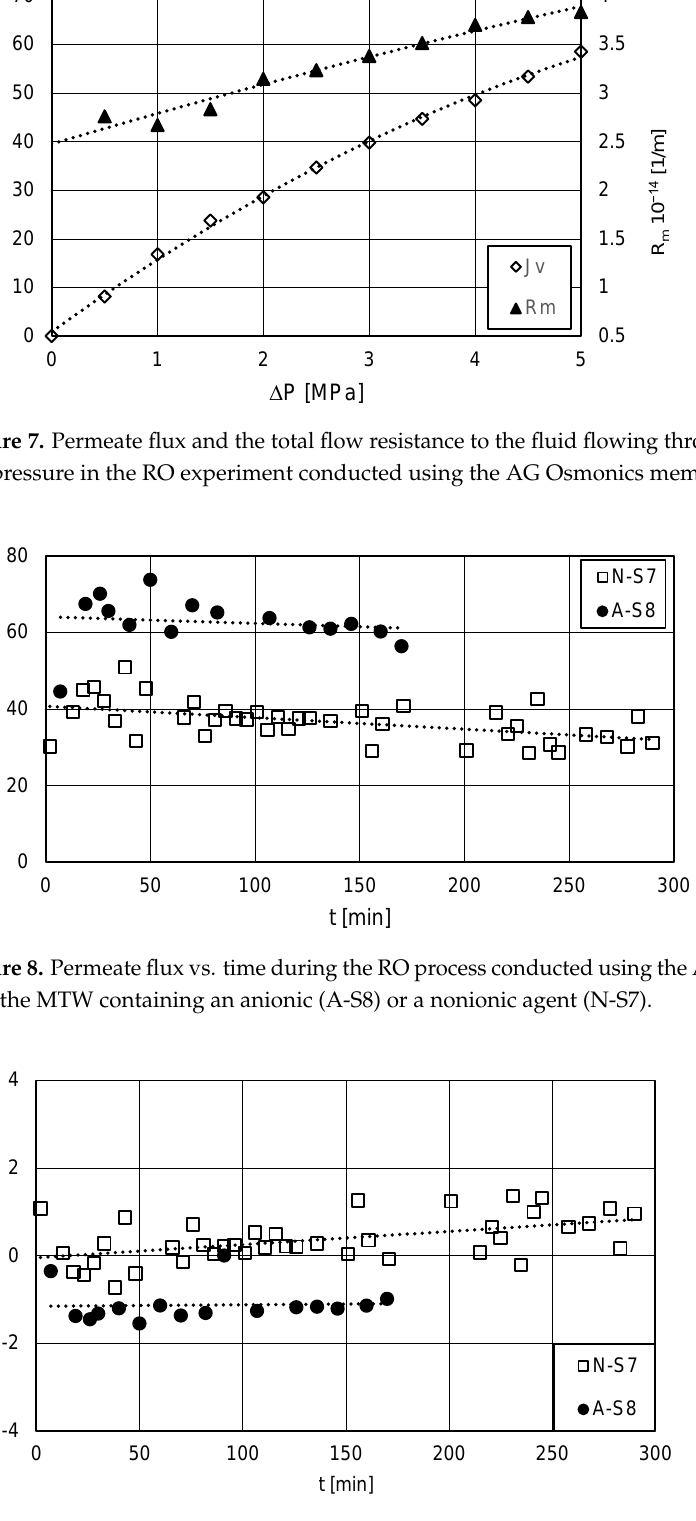
Figure 9. Difference in the hydraulic resistance vs. time in the RO process carried out using the MTW containing an anionic (A-S8) or a nonionic (N-S7) agent and in the RO process carried out using distilled water (AG Osmonics membrane).